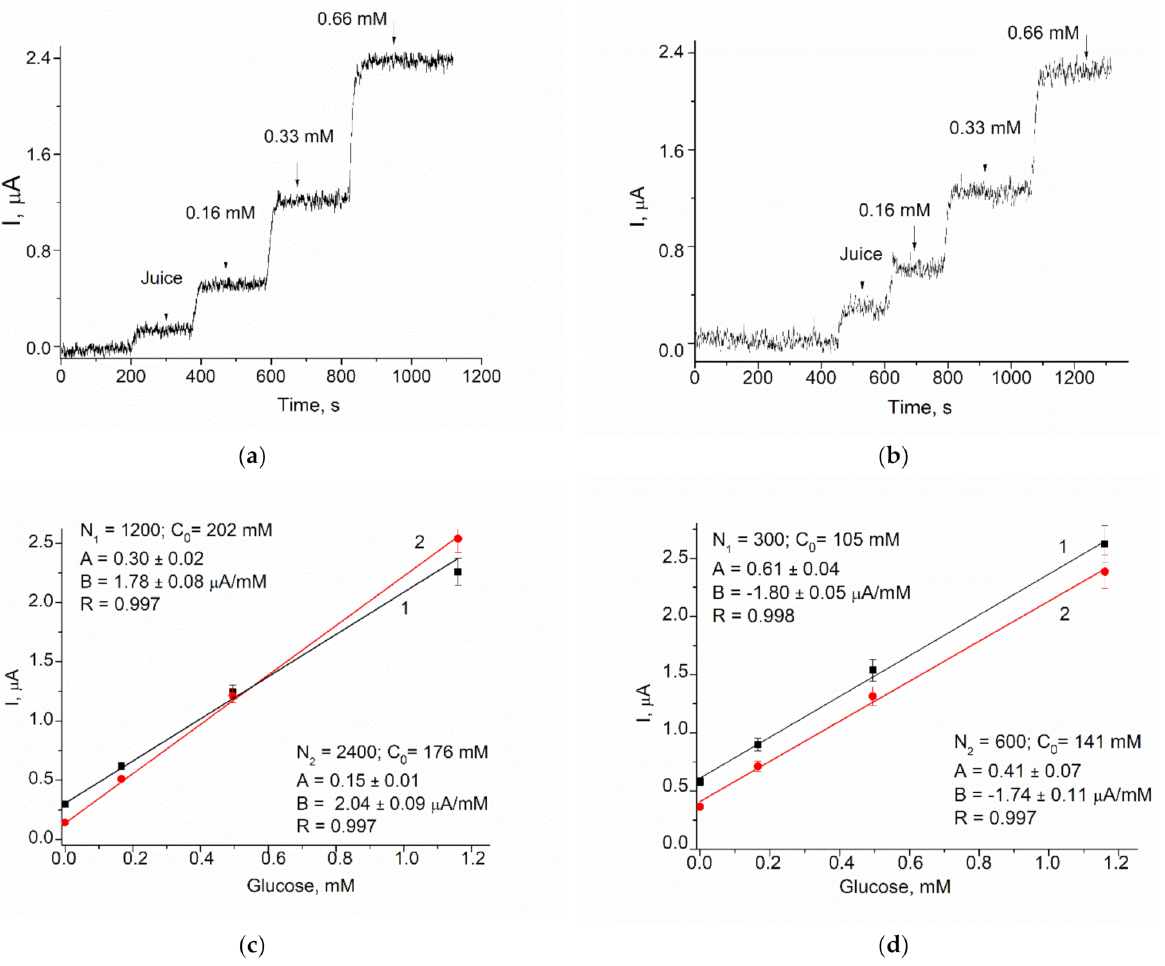
Figure 8. The example of glucose analysis using the biosensor in samples of juices: Multivitamin “Sadochok” ( a – c ), and apple–pear “Galicia” ( d ), in two dilutions; chronoamperograms ( a , b ), and corresponding linear graphs ( c , d ). Conditions: working potential − 250 mV vs. Ag/AgCl (reference electrode), 50 mM phosphate buffer, pH 6.0 at 23 ◦